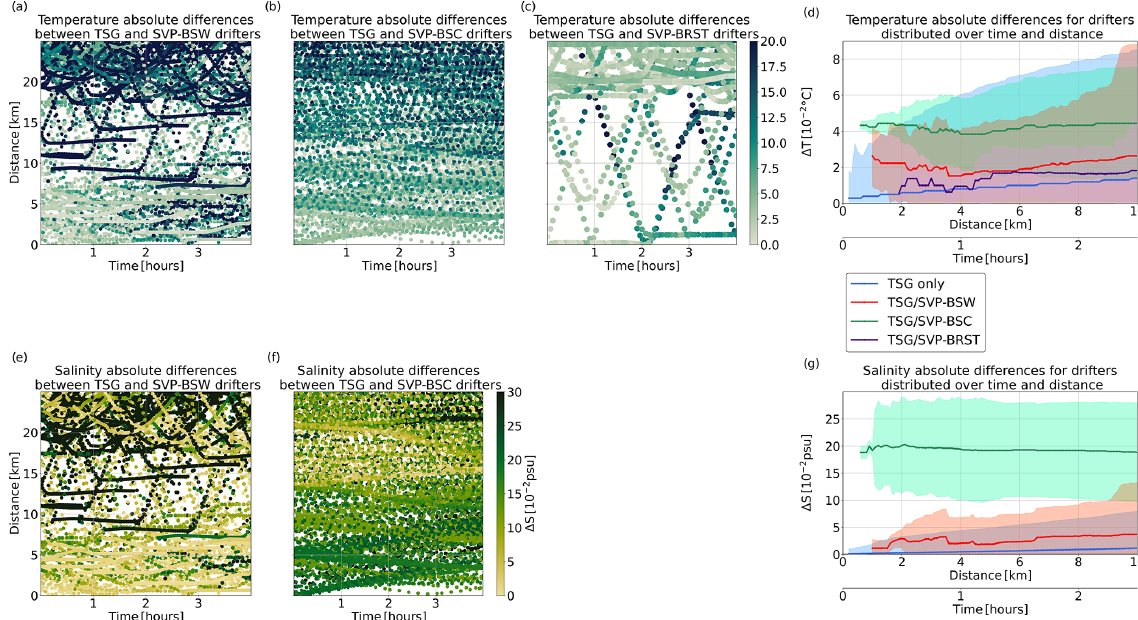
Figure 21. Panels (a) , (b) , and (c) show the absolute temperature differences between TSG/drifter pairs of measurements distributed in time and distance. Each pair is composed of one R/V’s TSG measurement and a drifter’s one. Respectively, panels (a) , (b) , and (c) , correspond to the SVP-BSW, SVP-BSC, and SVP-BRST drifters. (d) Temperature differences as a function of time and distance for a pair of surface measurements. Differences are shown in blue for pairs of CTD-only profiles, in red for pairs composed of one TSG and one SVP-BSW measurement, in green for pairs composed of one TSG and one SVP-BSC measurement, and in purple for pairs composed of one TSG and one SVP-BRST measurement. Panels (e) to (g) are the same as above line for absolute salinity differences without the SVP-BRST